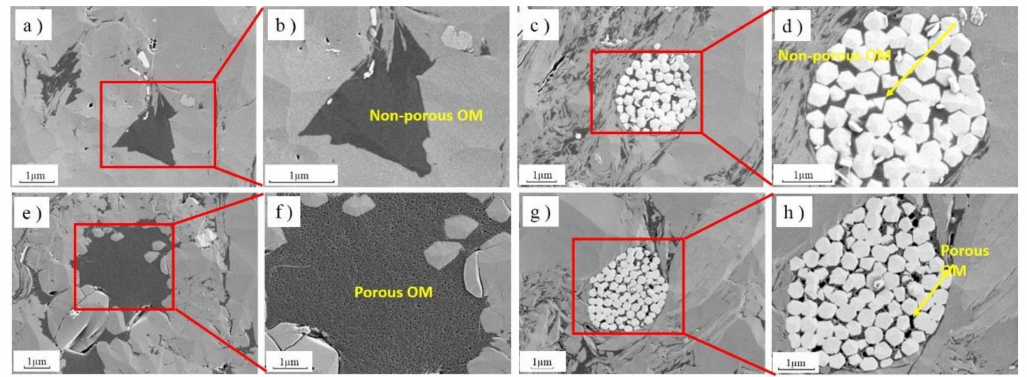
Figure 10. The FIB-SEM 2D images of OM-host pores and bulk OM: ( a – d ) are #3 and #5 samples of the lower Cambrian shale. ( e – h ) are #14 and #16 samples of the lower Silurian